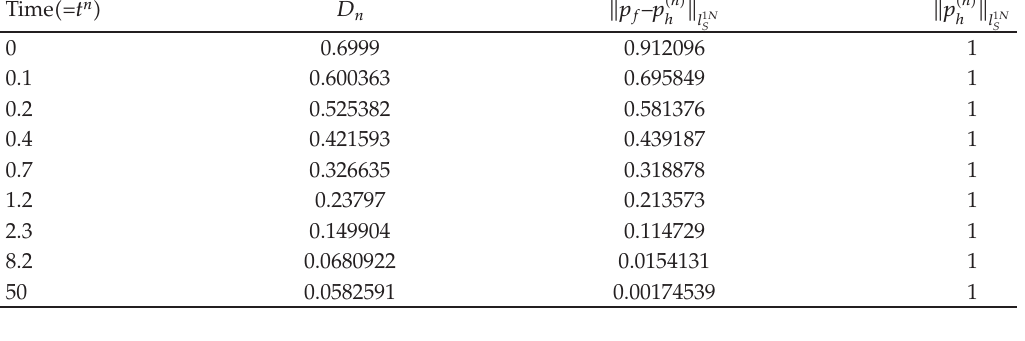
Table 3: Numerical results: Subcase 3.